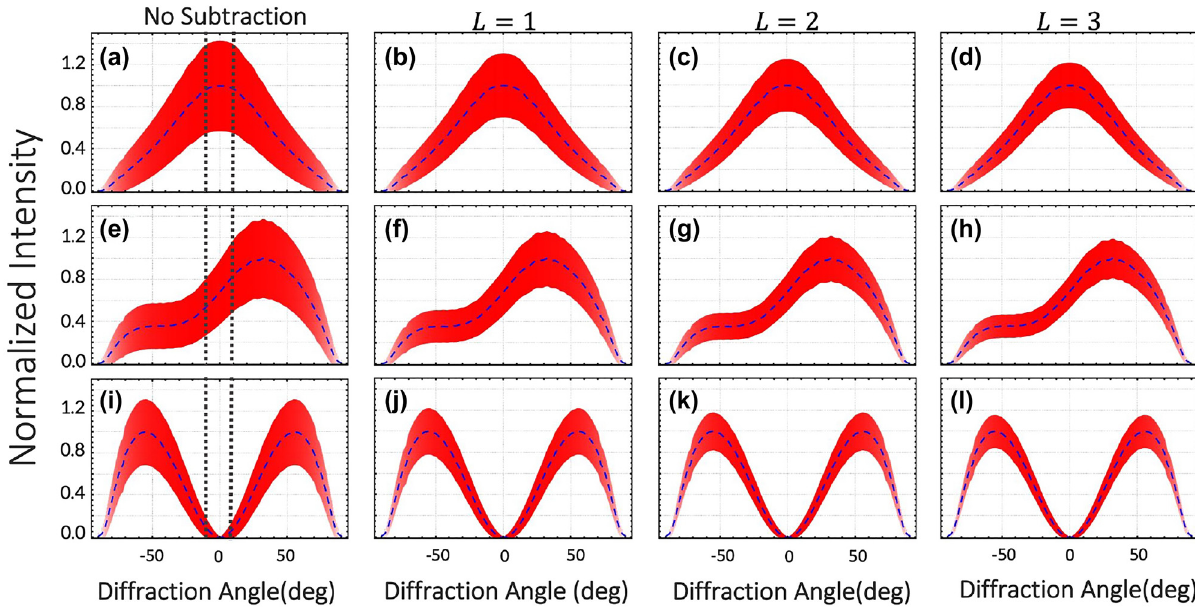
Figure 3: Normalized far-field intensity distribution scattered by the plasmonic nanoslit. The blue dashed line indicates the interference pattern produced by the field transmitted through the 320-nm-wide slit, this corresponds to mode ̂ e . The panels from (a) to (d) are obtained for 𝜑 = 0, whereas those from (e) to (h) and (i) to (l) are calculated for 𝜑 = 𝜋 ∕ 2 and 𝜑 = 𝜋 , respectively. The dashed line in all plots represents the intensity distribution of the fields transmitted through the slit indicative of dipolar and quadrupolar near-field symmetry for 𝜑 = 0 and 𝜑 = 𝜋 . The red shaded regions correspond to the standard deviation for ̄ n = 3 . 75. Panels (a), (e) and (i) depict the unconditional detection of the signal with its associated noise. As displayed in panels (b) to (d), (f) to (h) and (i) to (l), the signal-to-noise ratio of the plasmonic sensor improves as the fluctuations of the field are reduced through the conditional detection of plasmons. The vertical lines on panels (a), (e) and (i) represent the angular range used for the calculation of the intensity variation with phase (i.e. sensitivity depicted in Figure 4b).